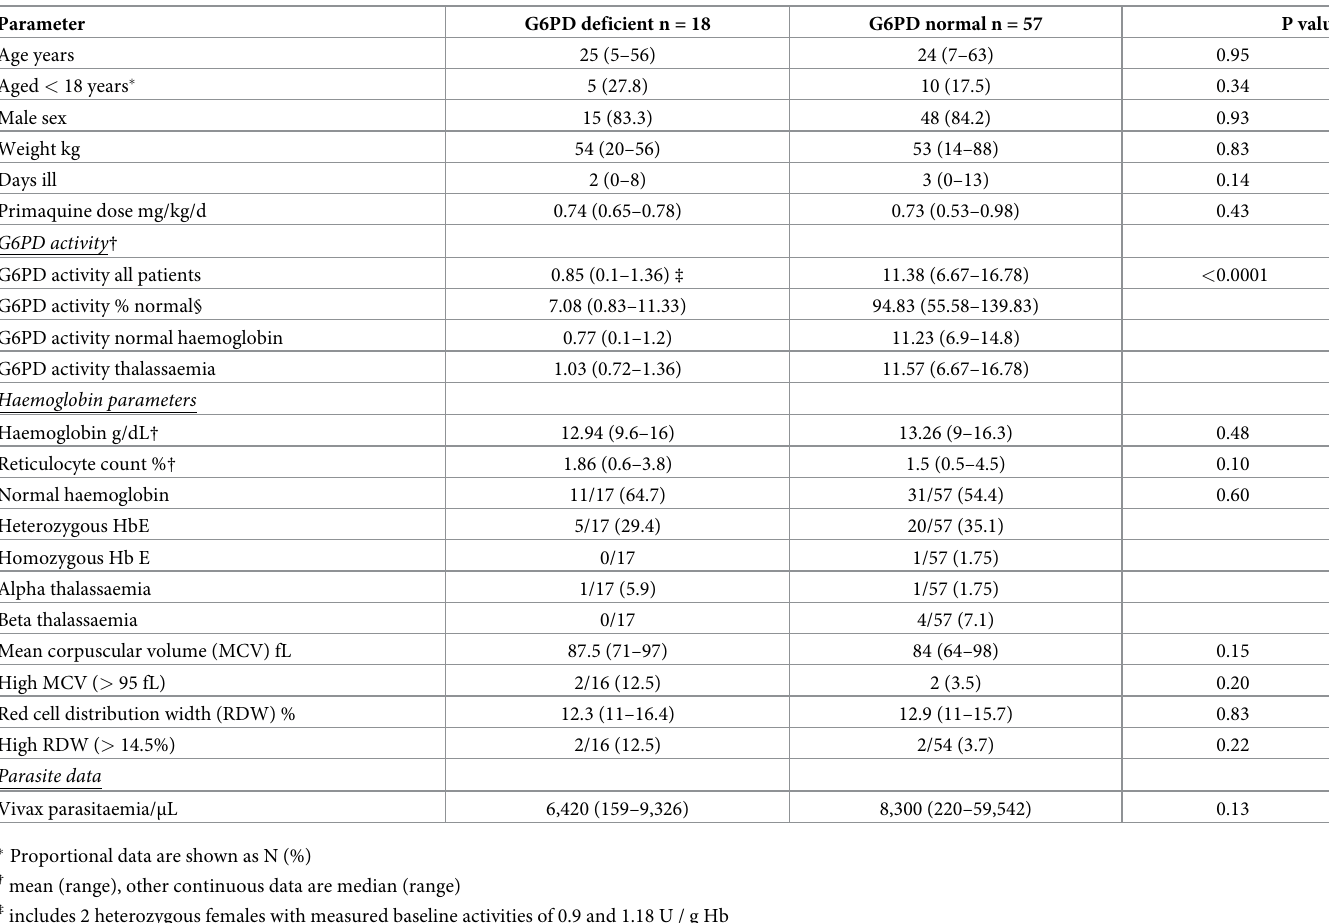
Table 1. Patients’ baseline